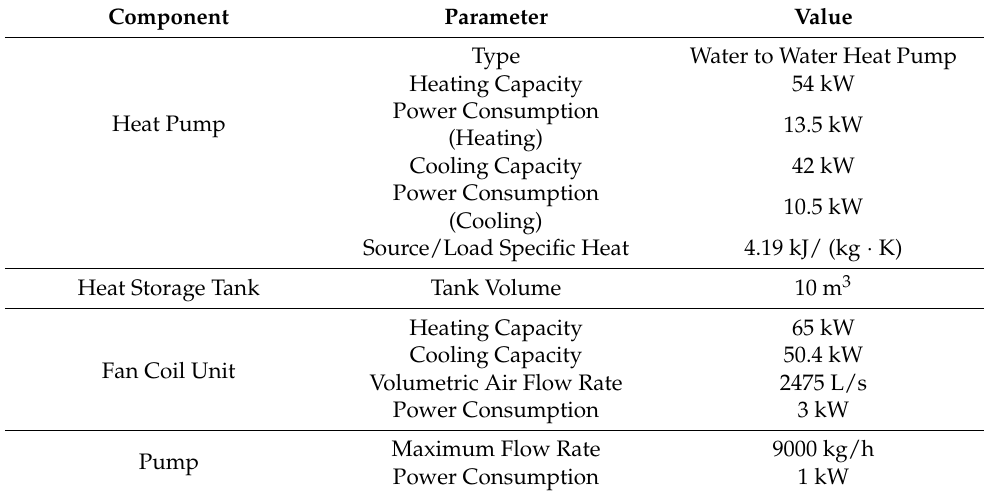
Table 3. Specifications of simulation